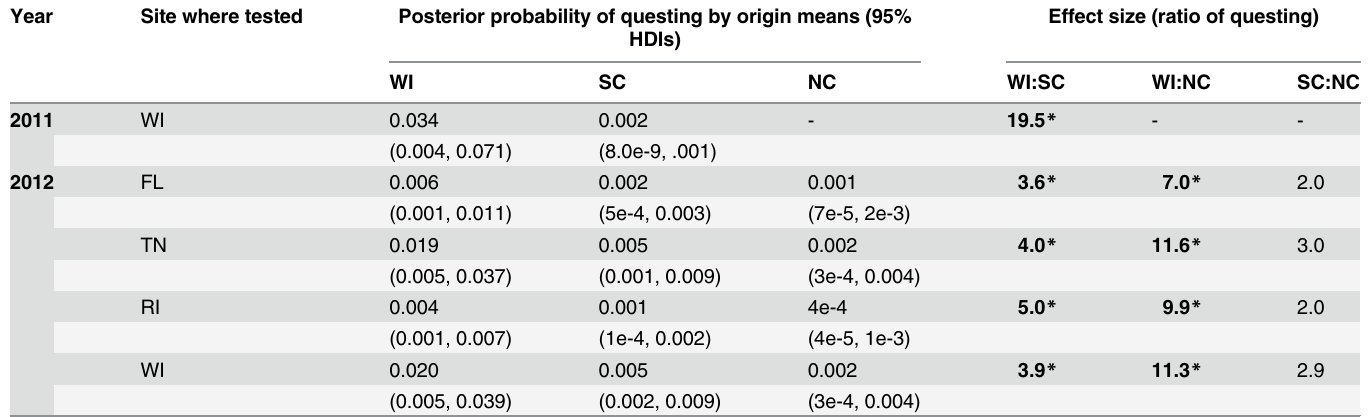
Table 1. Probability of nymph questing as a function of nymph